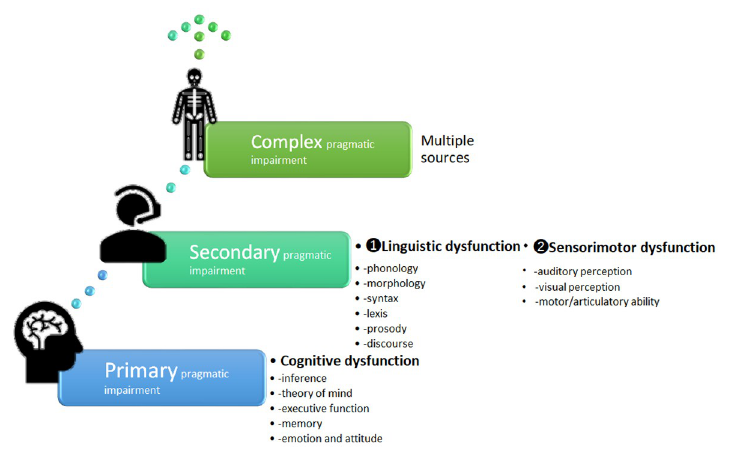
Fig 2. A classification scheme for PI and underlying causes (adapted from